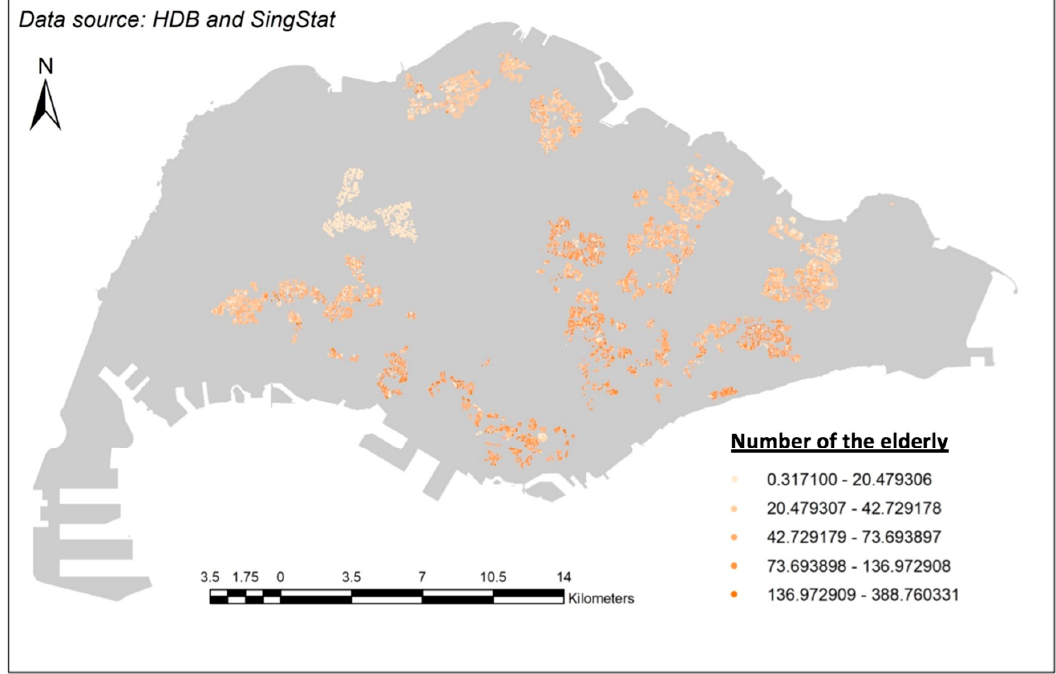
Figure 3. Density map of elderly living in HDB flats in Singapore.